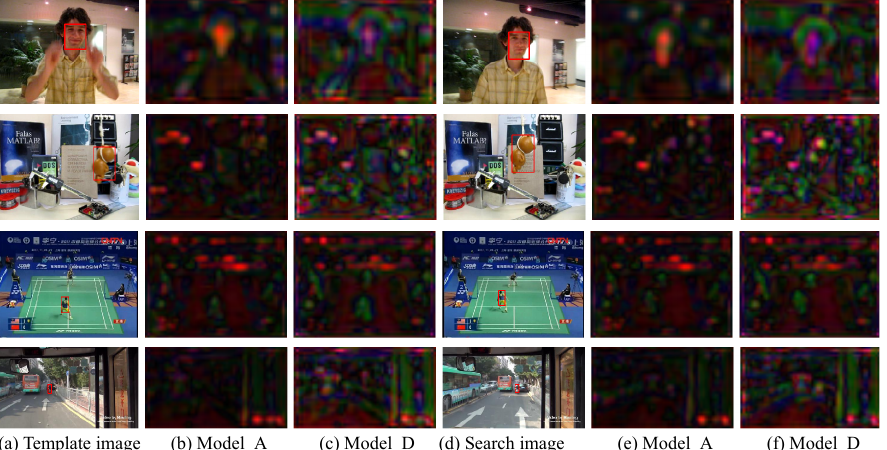
Figure 5. Visualisation of conv4_4 layers for image pairs with different template sizes: ( a ) the first image in the pair shows the bounding box defining the template; ( b , c ) visualisations of the corre- sponding features produced in layer conv4_4 of ( b ) Model_A and ( c ) Model_D; ( d ) the second image in the pair shows the bounding box of the ground truth location of the target object; ( e , f ) visualisations of the corresponding features produced in layer conv4_4 of Model_A and Model_D,